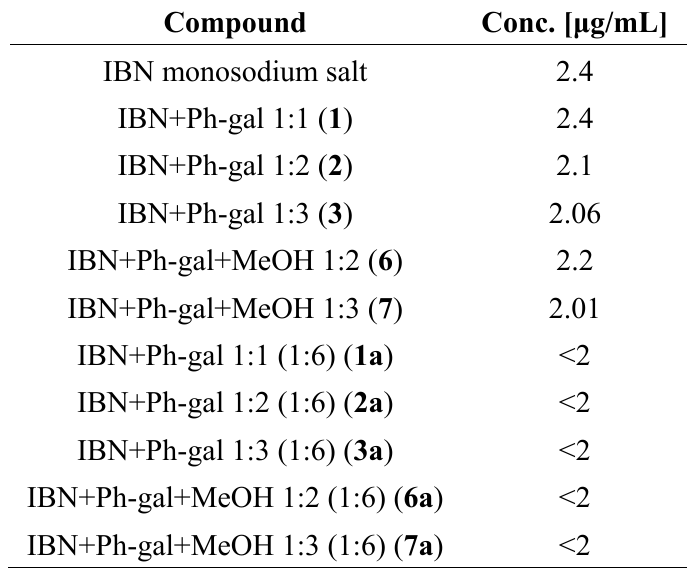
Table 2. Concentration of ibandronate standard and co-crystal samples 1 - 3 , 6 , 7 , 1a - 3a , 6a and 7a in acceptor solutions of PAMPA plates. Data for PAMPA were calculated from 5